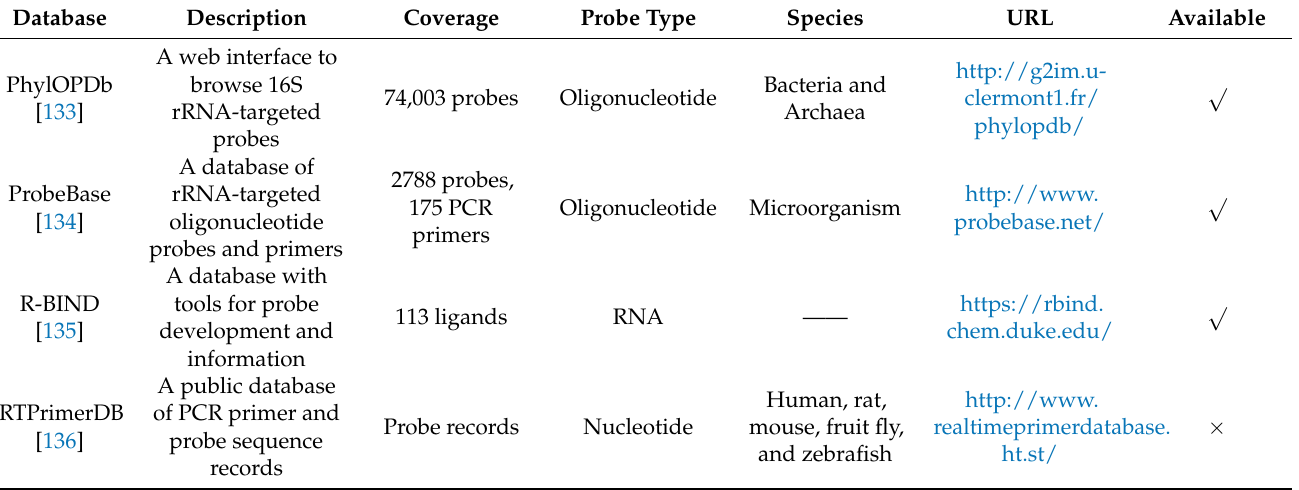
Table 5. Probe databases for the identification of binding sites and assessment of druggability.